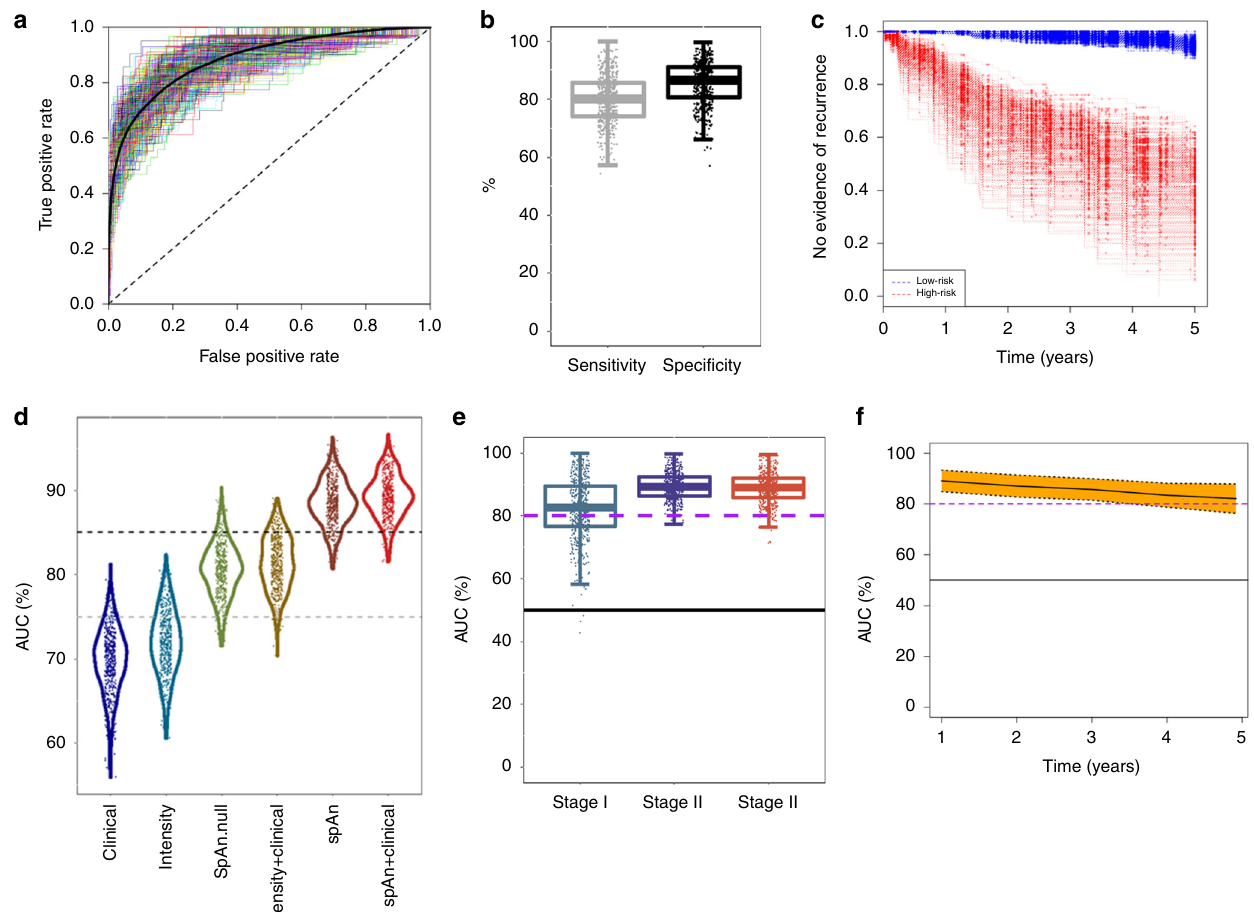
Fig. 4 Performance of SpAn in predicting 5-year CRC-recurrence risk. a SpAn receiver operating characteristics (ROC) curves for predicting risk of 5-year CRC recurrence in patients with resected CRC primary tumor. The plot shows ROC curves, rendered in different colors for improved visual contrast, for 500 bootstrap runs with independent training and validation sets. Area under the mean ROC curve, shown as a black-solid curve, is 88.5% with a standard error of 0.1%. The black dashed 45-degree line indicates random guessing. b Boxplots of the sensitivity and speci fi city values for the same 500 bootstrap runs as in ( a ) with the operating point on the ROCs chosen by minimizing overall misdiagnosis rate. The mean sensitivity and speci fi city values, respectively, are 80.3% (standard error of 0.4%) and 85.1% (standard error of 0.3%). (Box plot center line: median value; box bounds: interquartile range (IQR); upper whisker: 3rd quartile + 1.5 IQR; lower whisker: 1st quartile − 1.5 IQR). c Kaplan – Meier recurrence-free survival curves for each of the 500 bootstrap runs for patients identi fi ed by SpAn at low and high risk of 5-year CRC recurrence. d AUC violin and boxplots of the bootstrapped ROC curves achieved by six CRC-recurrence prediction models. The models are (1) clinical model, (2) biomarker expression model (denoted by intensity), (3) SpAn. null model (denoting SpAn without spatial-domain context), (4) biomarker expression + clinical model, (5) SpAn, and (6) SpAn + clinical model. Five hundred bootstraps were used. Figure S8 lists the statistical signi fi cance of the pairwise performance comparisons between all the six models. The gray and black dashed lines represent ROC curves with AUC of 75% and 85%, respectively. e Boxplots of stage-based area under the 500 bootstrapped ROC curves showing the stable stage-based clinical performance of SpAn. The black-solid line indicates an AUC of 50% corresponding to random guessing. f Stable temporal performance of SpAn illustrated by the time-dependent AUC values plotted as a function of time in years. The 95% con fi dence interval computed using the 500 bootstraps is also shown by the yellow shaded area around the mean time-dependent AUC values depicted by the black-solid curve. The 0.8 and 0.5 AUC values are shown for reference by the purple-dashed and black-solid lines,